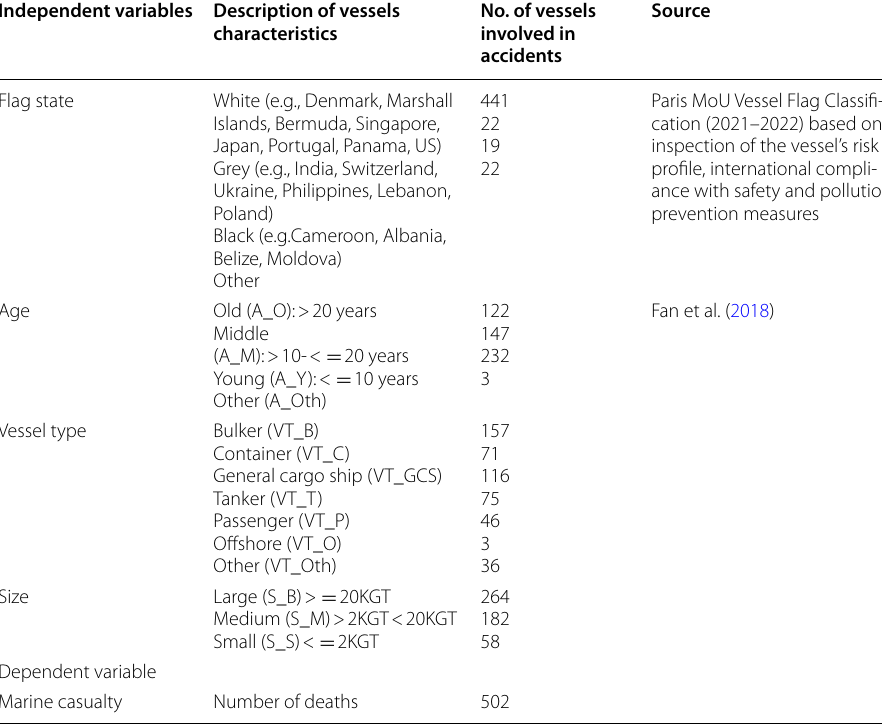
* Total number of injuries